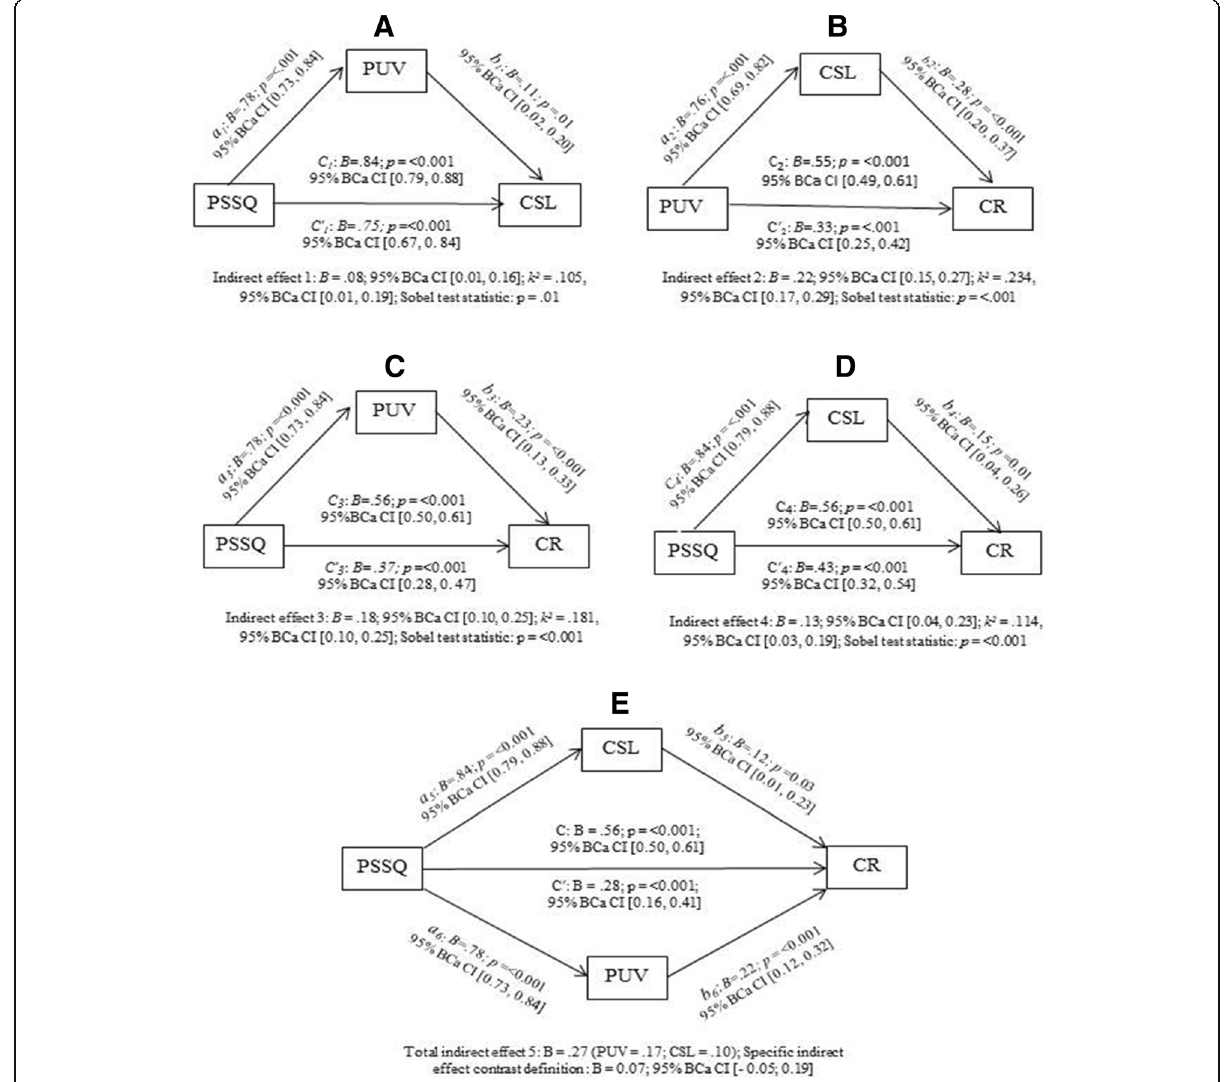
Fig. 2 Illustrations of simple mediation ( a , b , c & d and multiple mediation e ). Note: 95% BCa CI refers 95% bias corrected and accelerated confidence interval; k 2 stands for